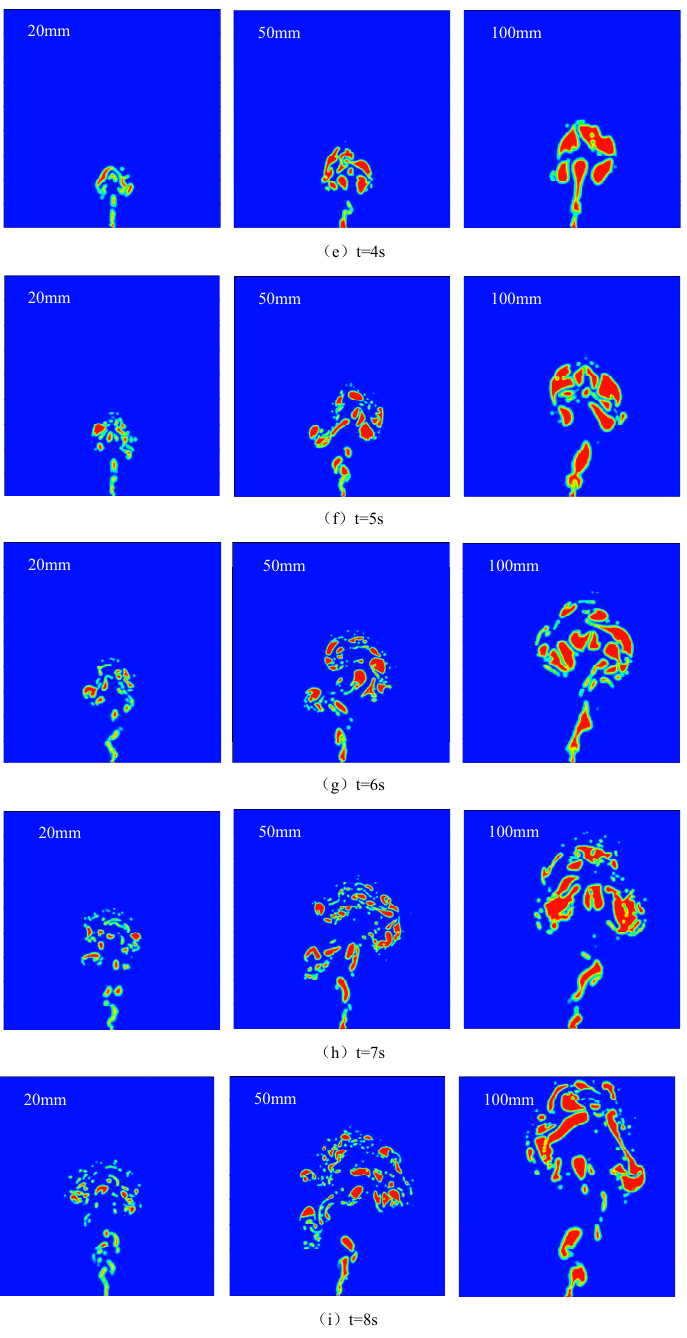
Figure 6. Leakage and diffusion nephogram of submarine natural gas at each time when the leakage aperture is 20 mm, 50 mm and 100 mm respectively.